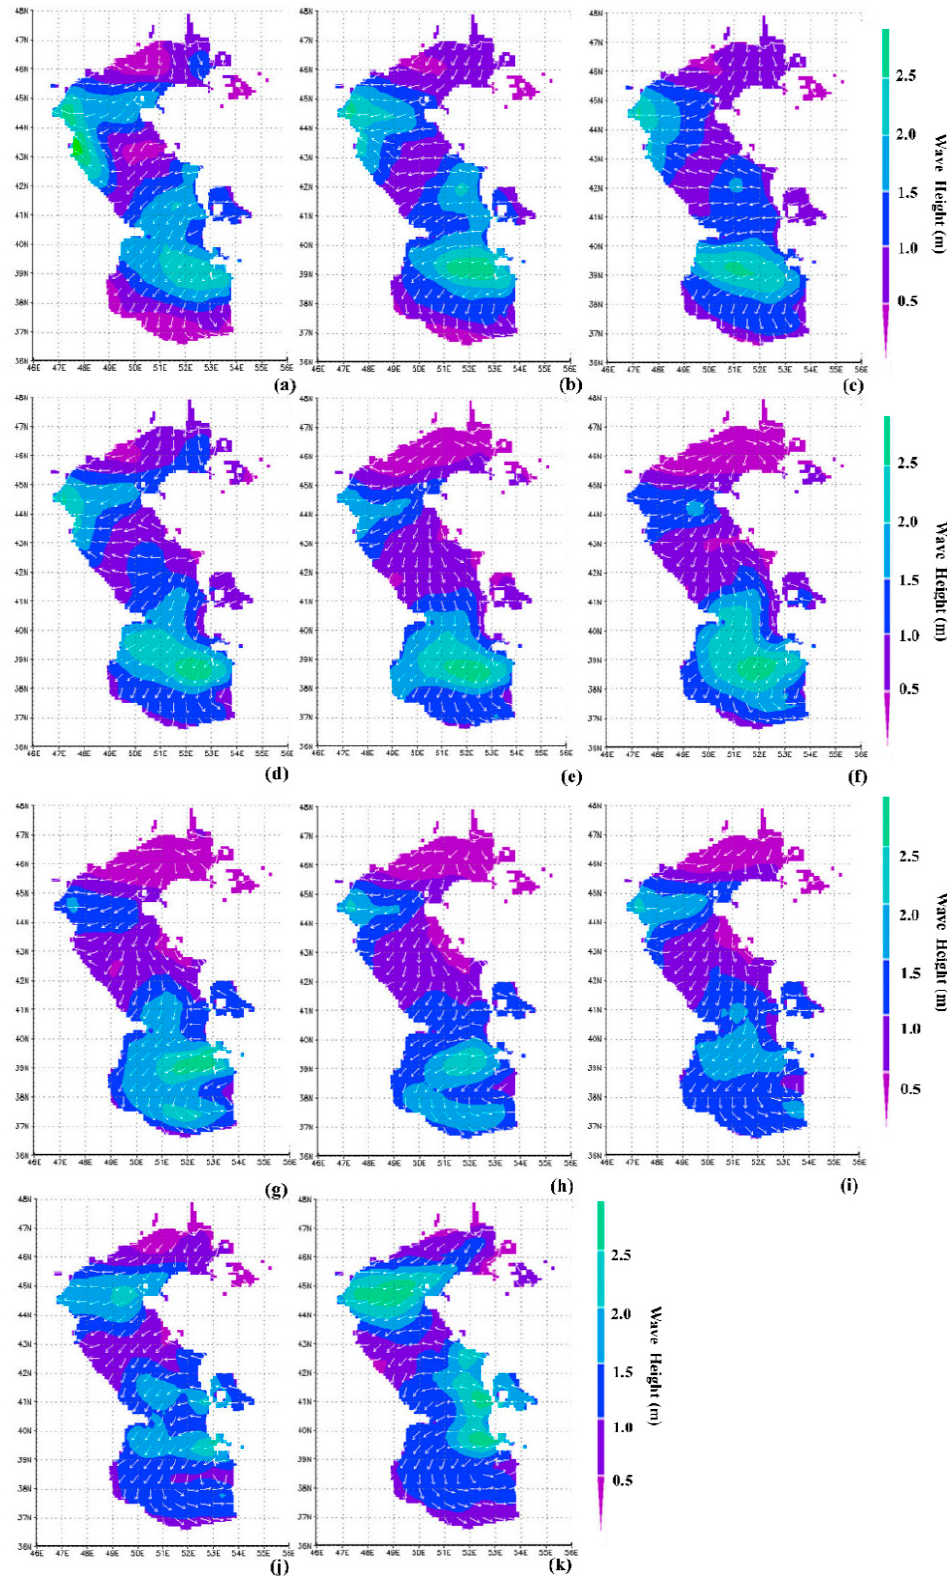
Figure 5. Detailed maps of monthly mean satellite-based wave heights (m) over Caspian Sea flow area in ( a ) January, ( b ) February, ( c ) March, ( d ) April, ( e ) May, ( f ) June, ( g ) July, ( h ) August, ( i ) September, ( j ) October, and ( k ) November 2016. The white arrows in all figures indicate the wind velocities, with arrows’ length proportional to speed magnitude, based on 10 knots unit.